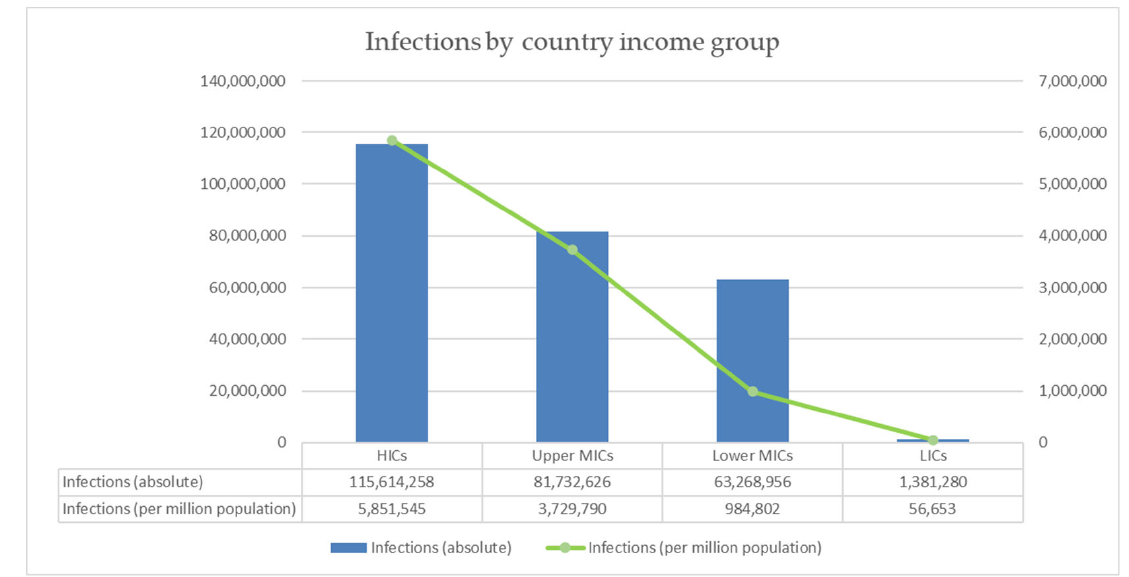
Figure 3. Global estimates of global SARS ‐ CoV ‐ 2 infections as of 1 December 2021, derived from Ritchie et al. 2020.